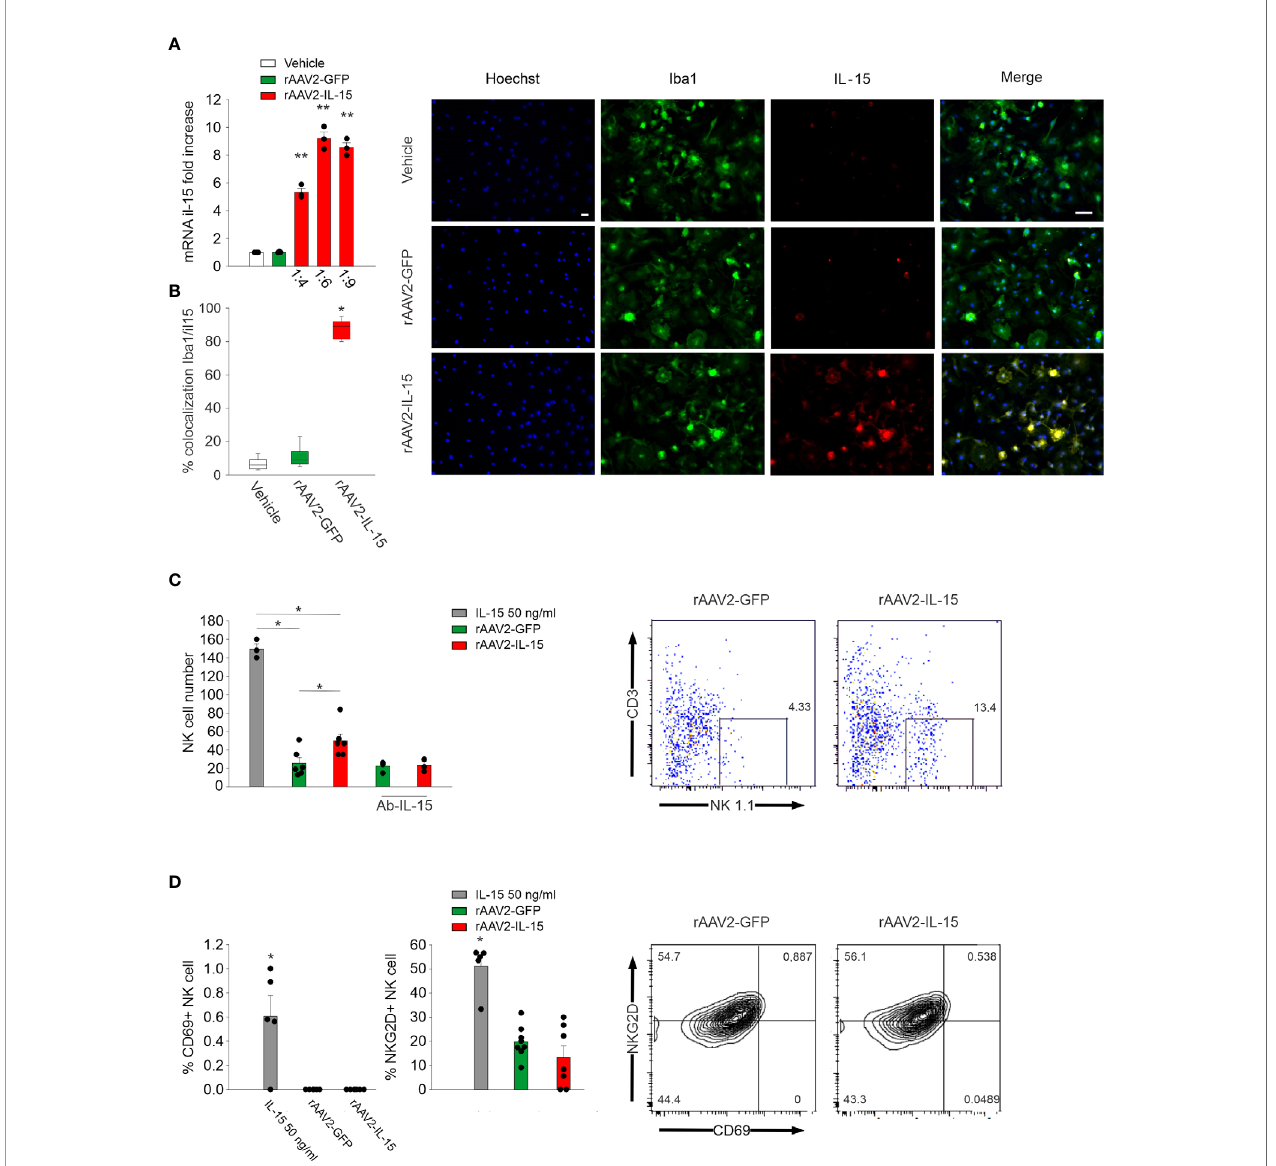
FIGURE 1 | rAAV2-IL-15-infected microglia increase NK cell viability. (A) RT-PCR of the il-15 gene in primary microglia obtained from pups (P0 – 2) incubated for 7 days with vehicle, rAAV2-GFP, and rAAV2-IL-15 at different dilutions (n = 3, data are the mean ± s.e.m, **p < 0.01 one-way ANOVA). (B) Colocalization of IL-15- and Iba1- covered areas in primary culture of microglia treated with vehicle, rAAV2-GFP, and rAAV2-IL-15 (1:9) for 7 days (n = 6 data are the mean ± s.e.m. **p < 0.01 one-way ANOVA). For boxplots, the center line, boxes, and whiskers represent the median, inner quartiles, and the rest of the data distribution, respectively. Right: representative immuno fl uorescence of primary cultured microglia (stained with Iba1 in green) and IL-15 (red). Scale bar: 20 µm. (C, D) After 7 days of incubation with rAAV2-GFP and rAAV2-IL-15 (1:9), primary cultures of microglia were incubated with NK cells, isolated from the spleen of C57BL/6 mice, in a 1:1 ratio, in the presence of IL-15 (50 ng/ml), a speci fi c Ab against IL-15 or vehicle; NK cell number (C) and CD69+ and NKG2D+ NK cells (D) were assessed by FACS analyses (n = 6, *p < 0.05 one-way ANOVA). Error bars show mean ±